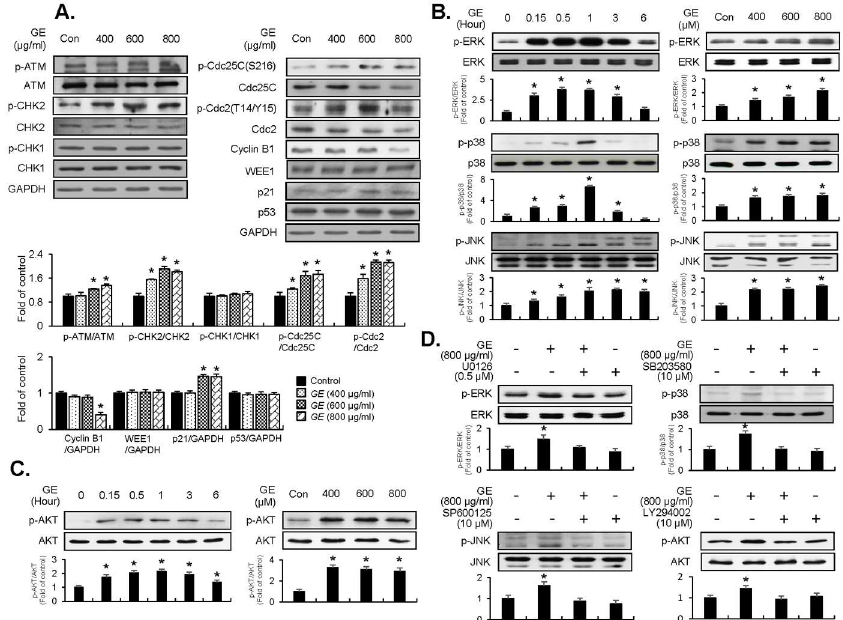
Fig 2. Effect of GE on G 2 /M-phase associatedcell-cycle regulators and signaling pathways in EJ cells. (A) Changesin cell cycle regulatorsby treatment of different concentrations of GE. Immunoblotswere performed using specific antibodies indicated.The bar graphs were presentedas a fold ratio to the control. (B, C) Effect of GE on MAPK (ERK1/2, JNK1/2, and p38) and AKT signaling. Phosphorylation levels of each moleculewere assessed by immunoblots. Bar graphs were presentedas fold changescomparedto the control. (D) EJ cells were pre-incubated with U0126(0.5 μ M), SB203580(10 μ M), SP600125(10 μ M), and LY 294002(10 μ M) for 40 min prior to treatment with GE (800 μ g/ml). The ratio of phosphorylated to non- phosphorylated form was measured and presentedas fold changescompared to the control. Results in bar graphsare represented as mean ± SE from three different triplicate experiments. * P < 0.05compared with the